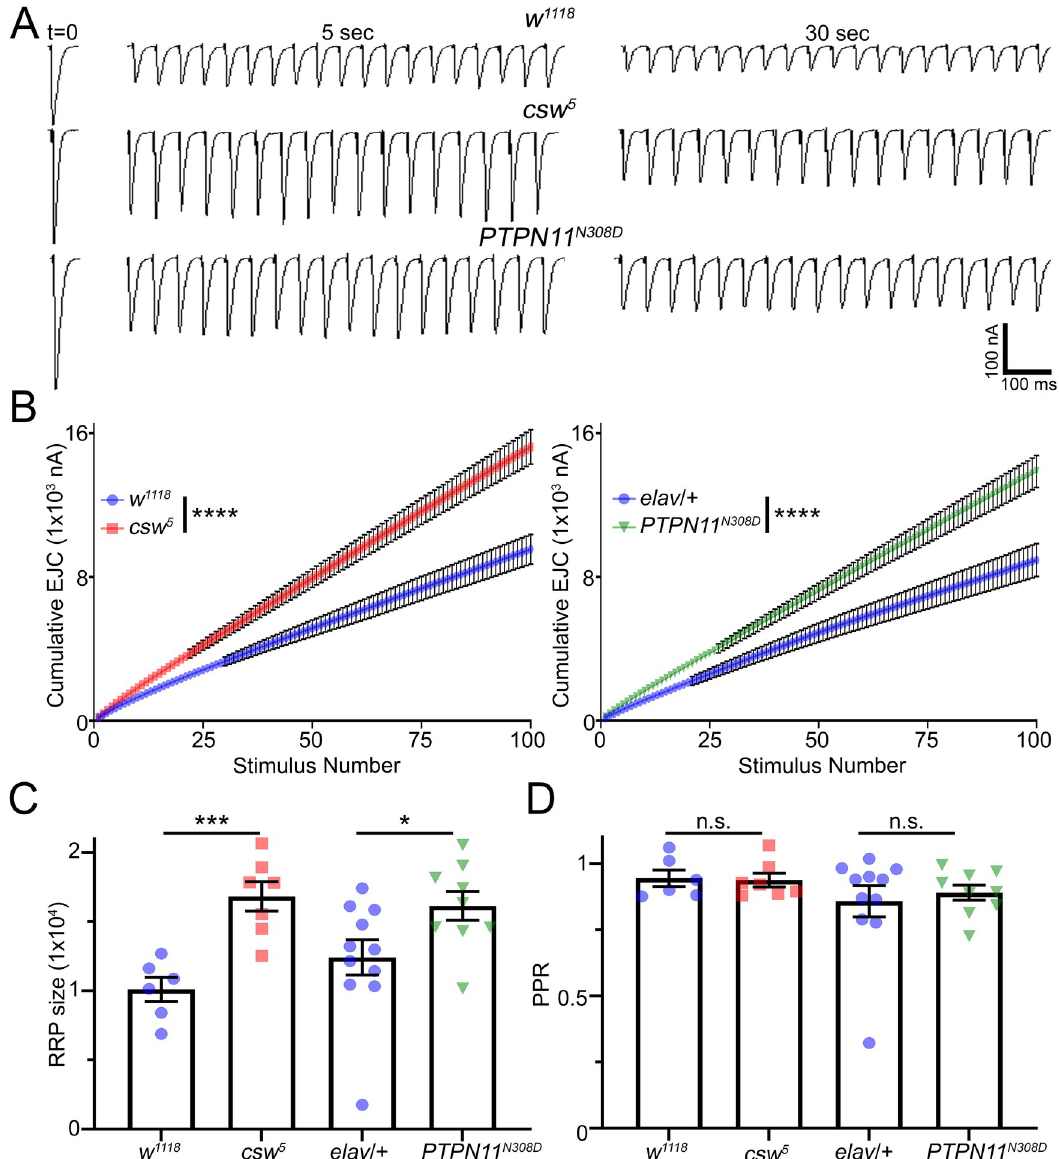
Fig 3. HFS transmission depression ameliorated in csw nulls. Prolonged HFS drives progressive synaptic amplitude depression over several minutes of continuous recording at 20 Hz (1mM Ca +2 ). ( A) Representative nerve-stimulated EJC traces at the basal frequency (t = 0) and indicated time points during the HFS train for genetic background control ( w 1118 , top), csw null ( csw 5 , middle), and PTPN11 N308D GoF mutant ( elav -Gal4 > PTPN11 N308D ; bottom). ( B) Quantification of cumulative EJC amplitudes over the first 100 stimulations via nonlinear regression exponential for each pair tested using extra sum-of-squares F tests. ( C) Quantification of the RRP of w 1118 and csw 5 (two-sided t test) and elav -Gal4/ w 1118 and PTPN11 N308D (Mann–Whitney). ( D) Quantification of the PPR of w 1118 and csw 5 (two-sided t test) and elav -Gal4/ w 1118 and PTPN11 N308D (Mann–Whitney). Scatter plots show all data points and mean ± SEM. N = number of NMJs. Significance: p < 0.05 ( � ), p < 0.001 ( �� ), p < 0.001 ( ��� ), and p < 0.0001 ( ���� ). The data underlying this figure can be found in S1 Data. csw , corkscrew; EJC, excitatory junction current; HFS, high-frequency stimulation; NMJ, neuromuscular junction; PPR, paired-pulse ratio; RRP, readily releasable